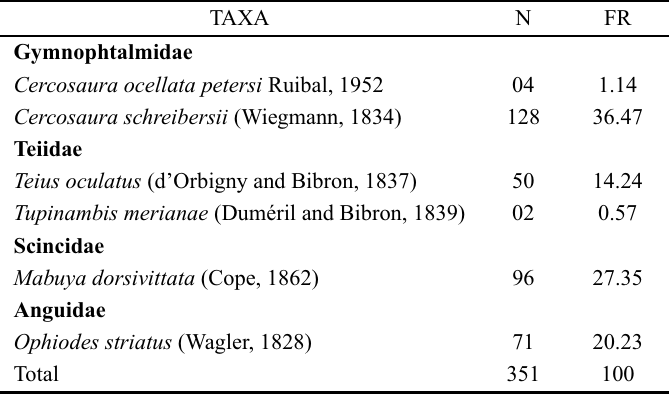
Richness and abundance of lizard species in the studied area, between February 2001 and January 2004, from the Pampa biome in Brazil. N = captures number; FR = relative frequency (%).